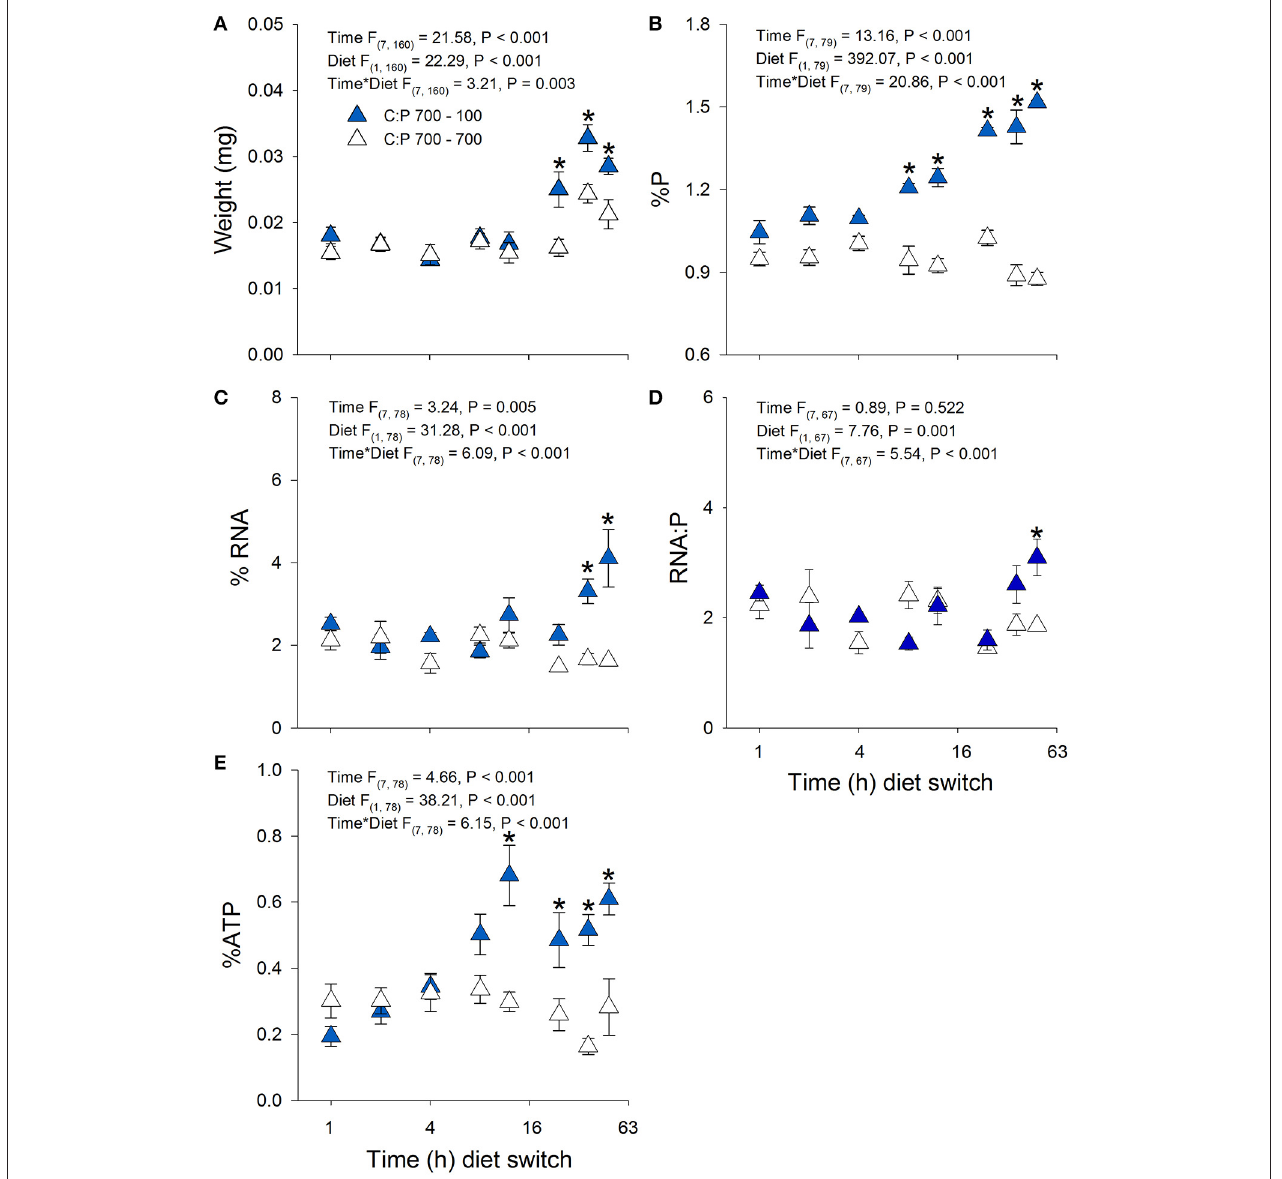
FIGURE 4 | Acute averages ± standard error in Daphnia mass (A) and metabolic P-pools ( B ; body %P, C ; body %RNA, D ; RNA:P, E ; body %ATP). White triangles are animals maintained at C:P 700 while dark blue triangles representing animals that were switched to C:P 100 * indicates significant changes between switched diets and non-switched diets ( P <